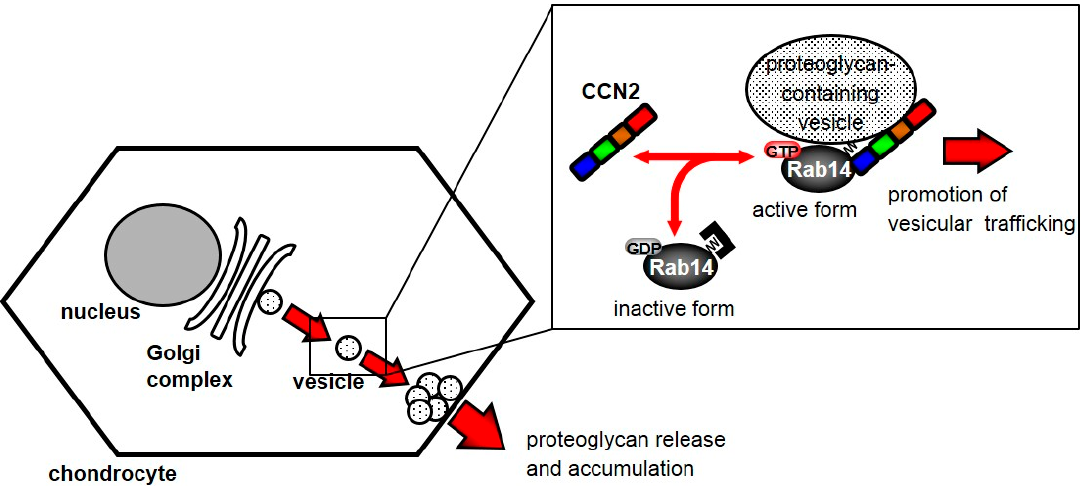
Figure 6. Schematic diagram showing the behavior of Rab14 and CCN2 in chondrocytes. Cytosolic Rab14 is recruited to the Golgi complex by the association with intracellular CCN2 and transports proteoglycan-containing vesicles from the Golgi complex to endosomes in chondrocytes.